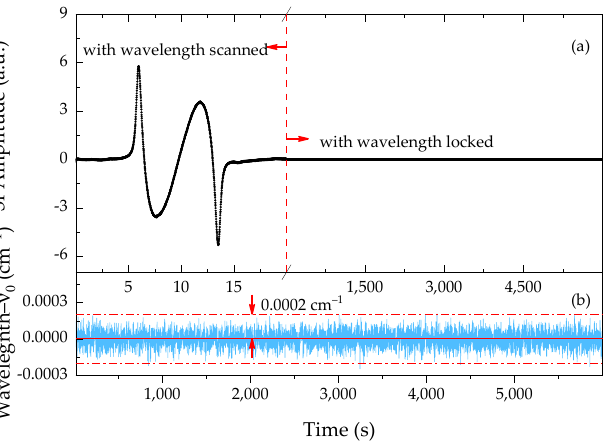
Figure 5. ( a ) 3 f amplitude of reference chamber under both laser wavelength slowly scanned mode and tightly locked mode. ( b ) Stable laser operation with its wavelength variation kept within 0.0002 cm − 1 over 6000 s, meanwhile, a feedback interval of 0.50514 s was chosen.